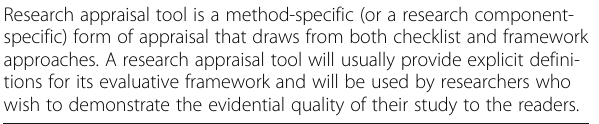
cohort study checklist,